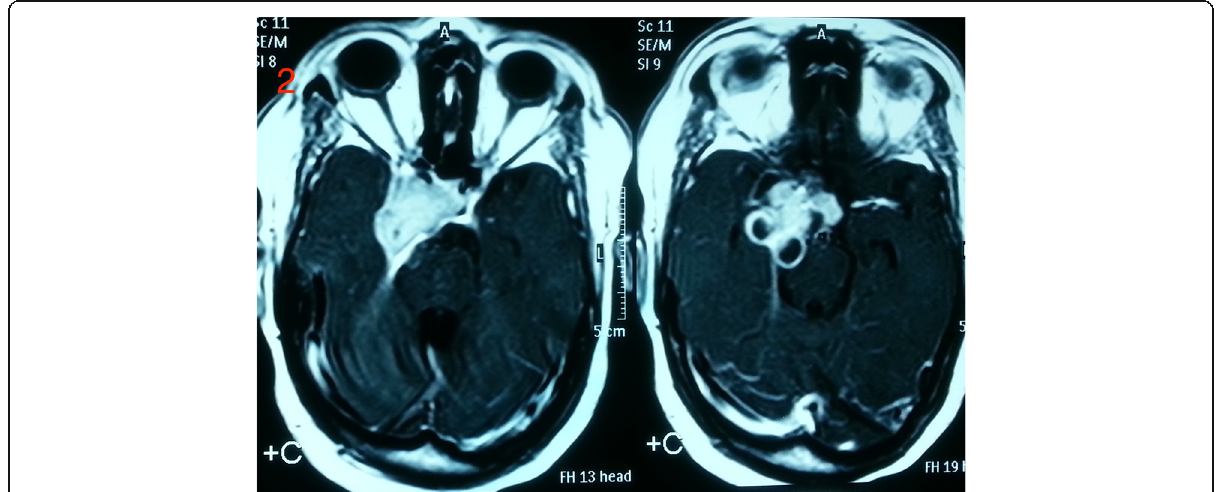
Fig. 2 MRI brain T1WI with contrast showing a case with doubtful diagnosis